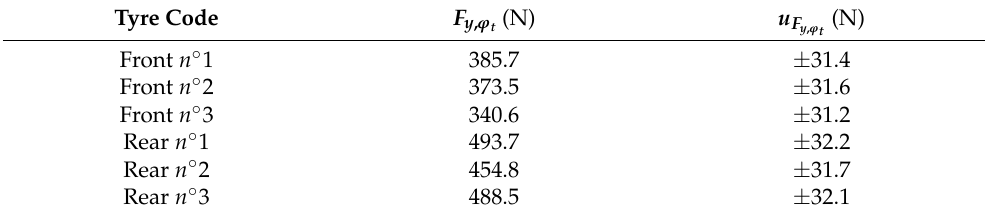
Table 1. Turn slip force estimation. Note that the force values are reported as absolute values: the tyre testing machine curvature direction generates negative turn slip